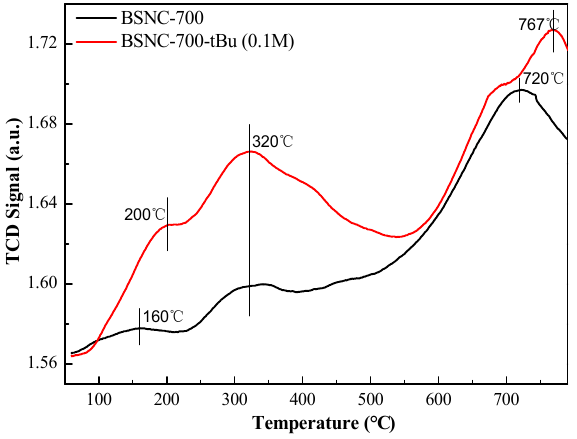
Figure 3. CO 2 -TPD curves of BSNC-700 and BSNC-700-tBu (0.1 M).